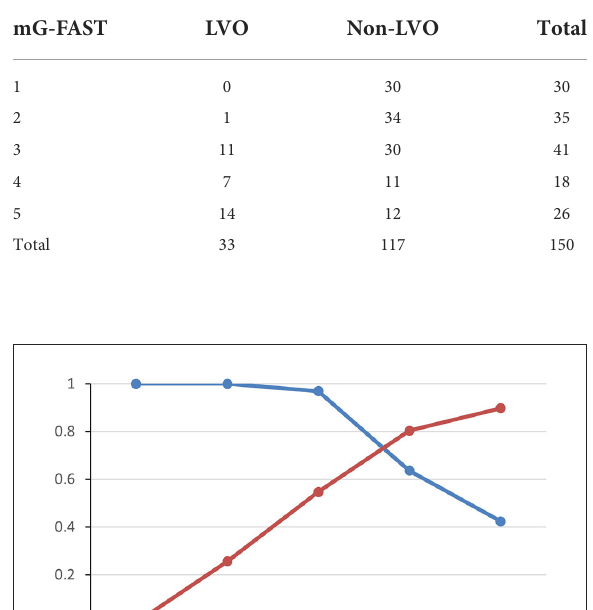
TABLE 4 Distribution of EMS mG-FAST scores of LVO and non-LVO stroke patients.